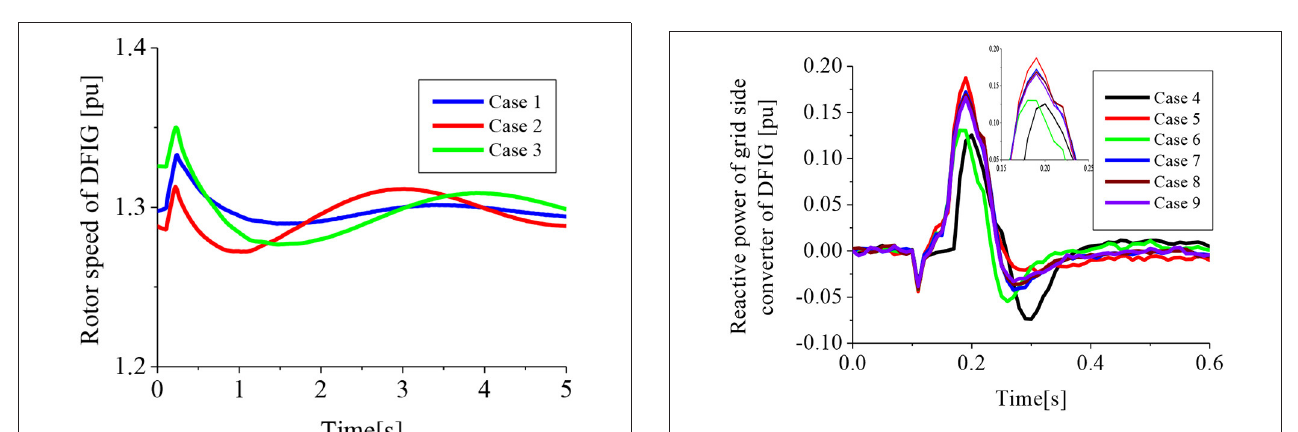
FIGURE 13 | Active power of DFIG (cases 4–9).